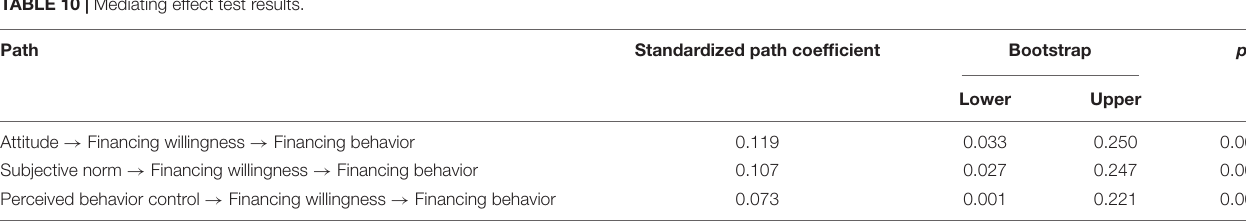
FIGURE 5 | Execution results in structural equation model (SEM). TABLE 10 | Mediating effect test